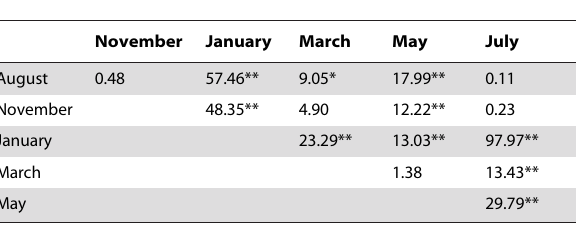
Table 4. Yates-corrected chi-square statistics between number of nulliparous and parous Anopheles darlingi in different collection